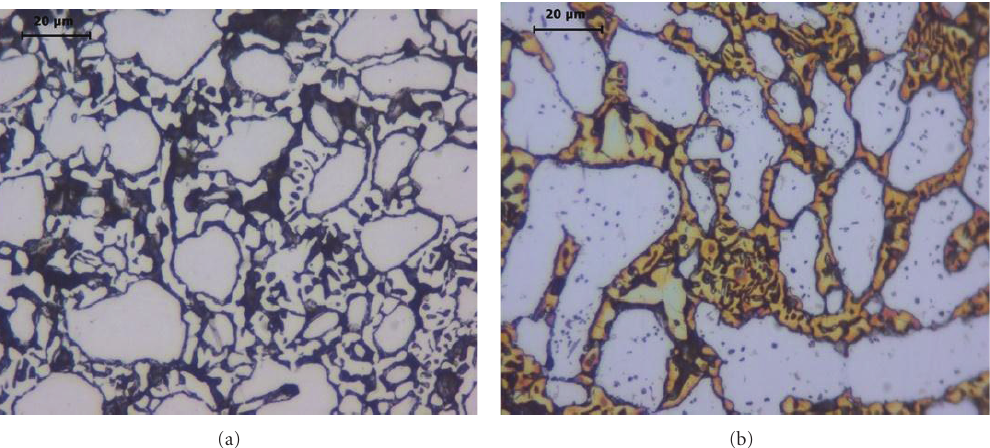
Figure 10: Optical micrographs after DLEPR test for sample aged at 800 ◦ C for 10000 min. (a) After slightly polished (large austenite in white, attacked regions in black, sigma: small white regions). (b) Electrolytically etched with NaOH (austenite in white, sigma in brown, attacked regions in black).